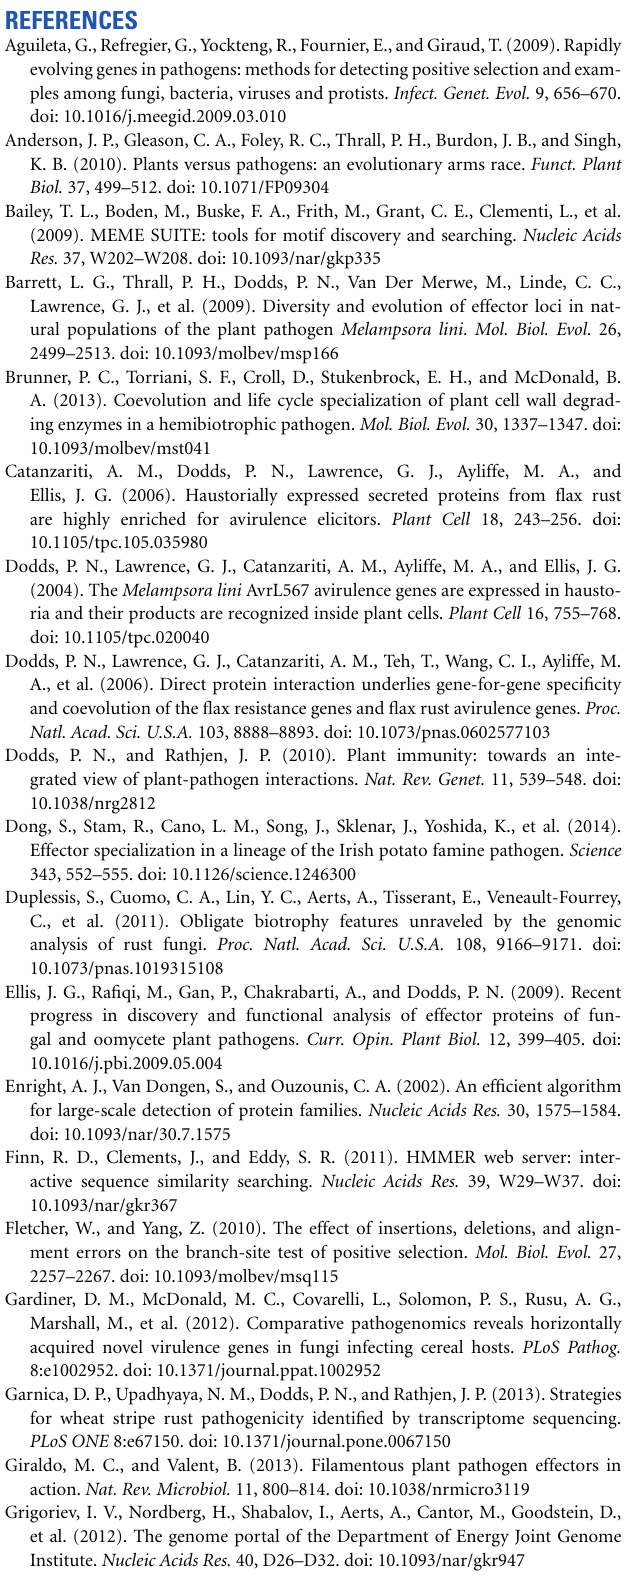
Table S1 | The list of fungal genomes used for comparative classification of gene families into pathogen-associated and